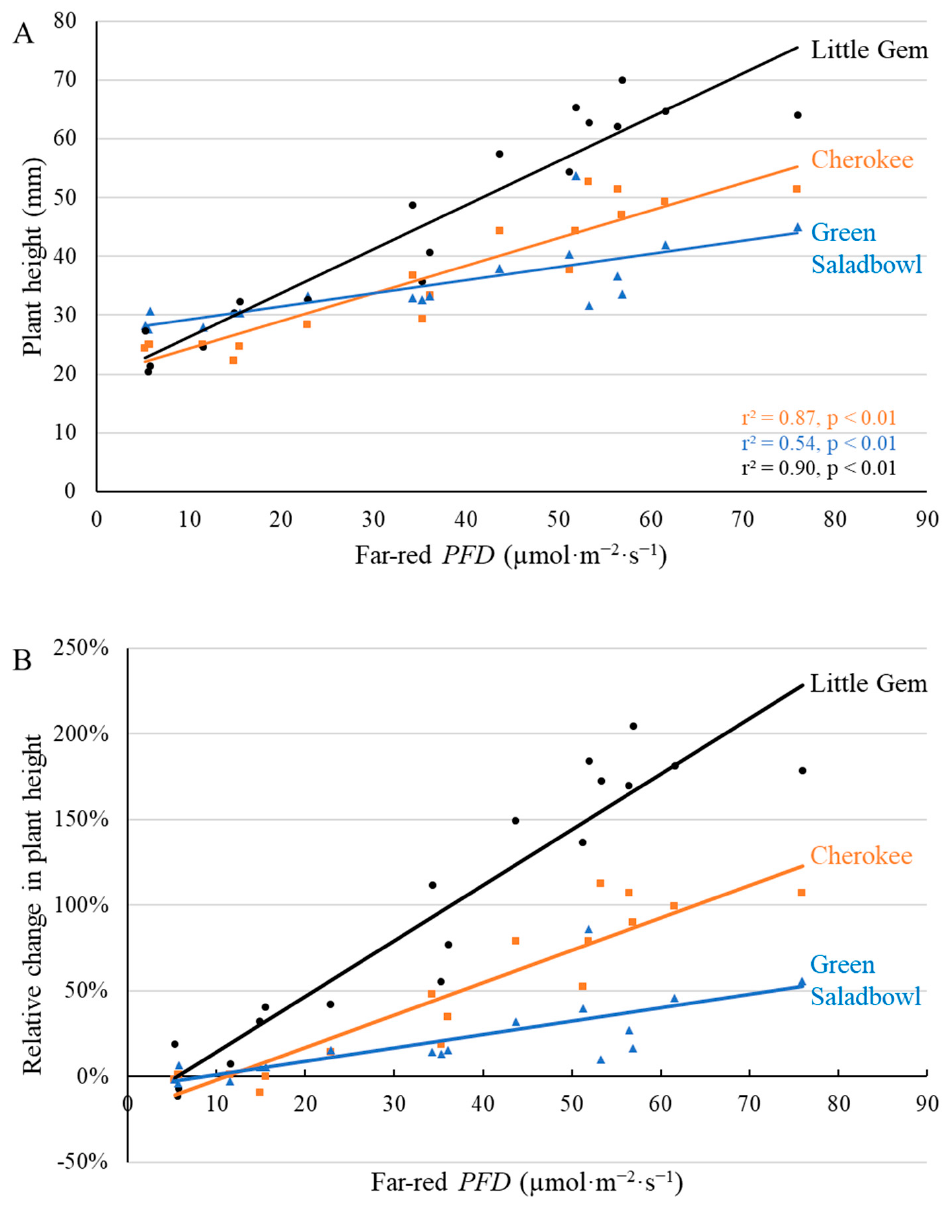
Figure 1. With a background of 204 µ mol · m − 2 · s − 1 white LED light, supplemental far-red photons linearly increased plant height ( A ) and the relative change in plant height (( B ), compared to plants under no supplemental far-red light) 7 days after the start of far-red light treatment for ‘Cherokee’, ‘Green Saladbowl’, and ‘Little Gem’ lettuce. The r 2 and p values for regression of each cultivar apply to both graphs and are shown with the respective color.